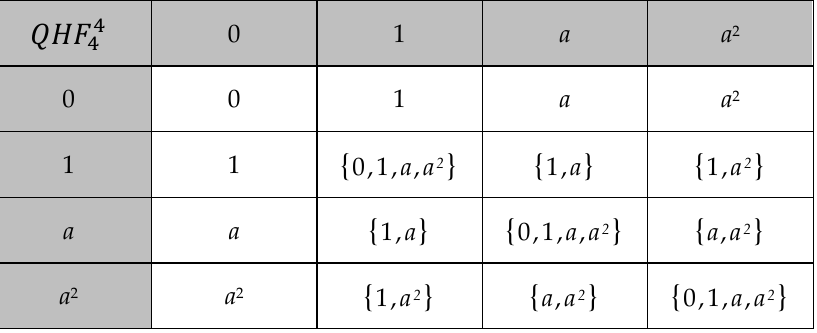
Table 9. The Cayley table of the canonical hypergroup of the quotient hyperfield of an infinite field by a multiplicative subgroup of index 3.